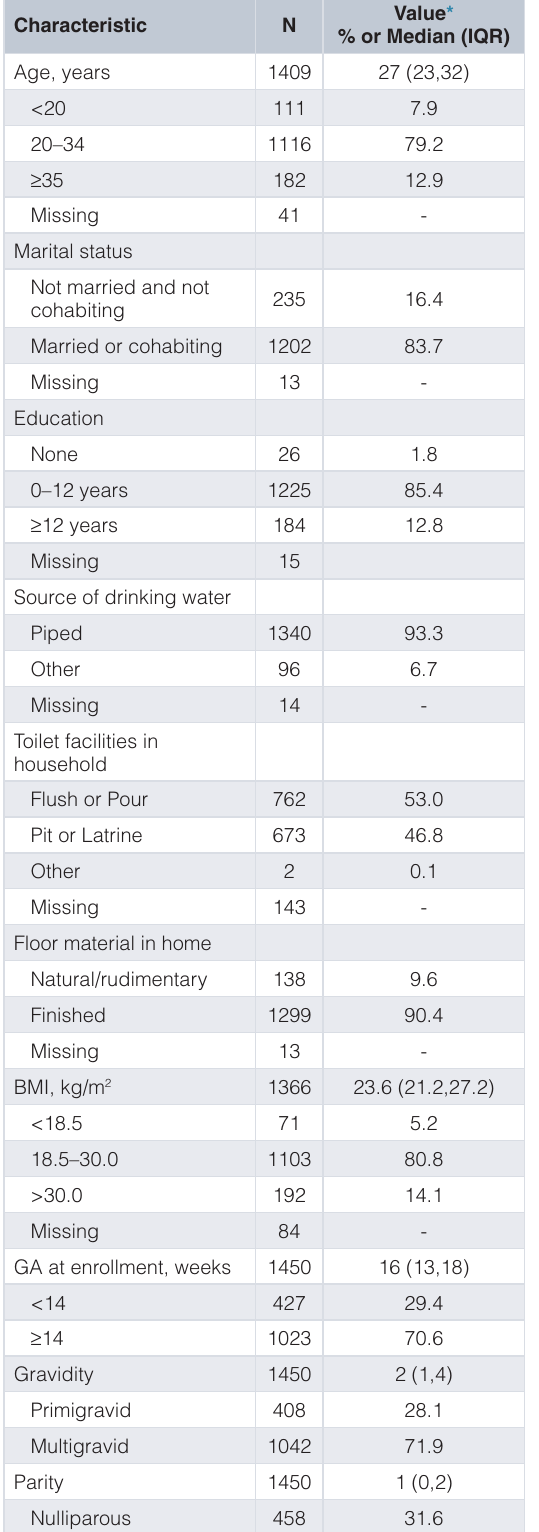
Table 2. Baseline characteristics of ZAPPS cohort,